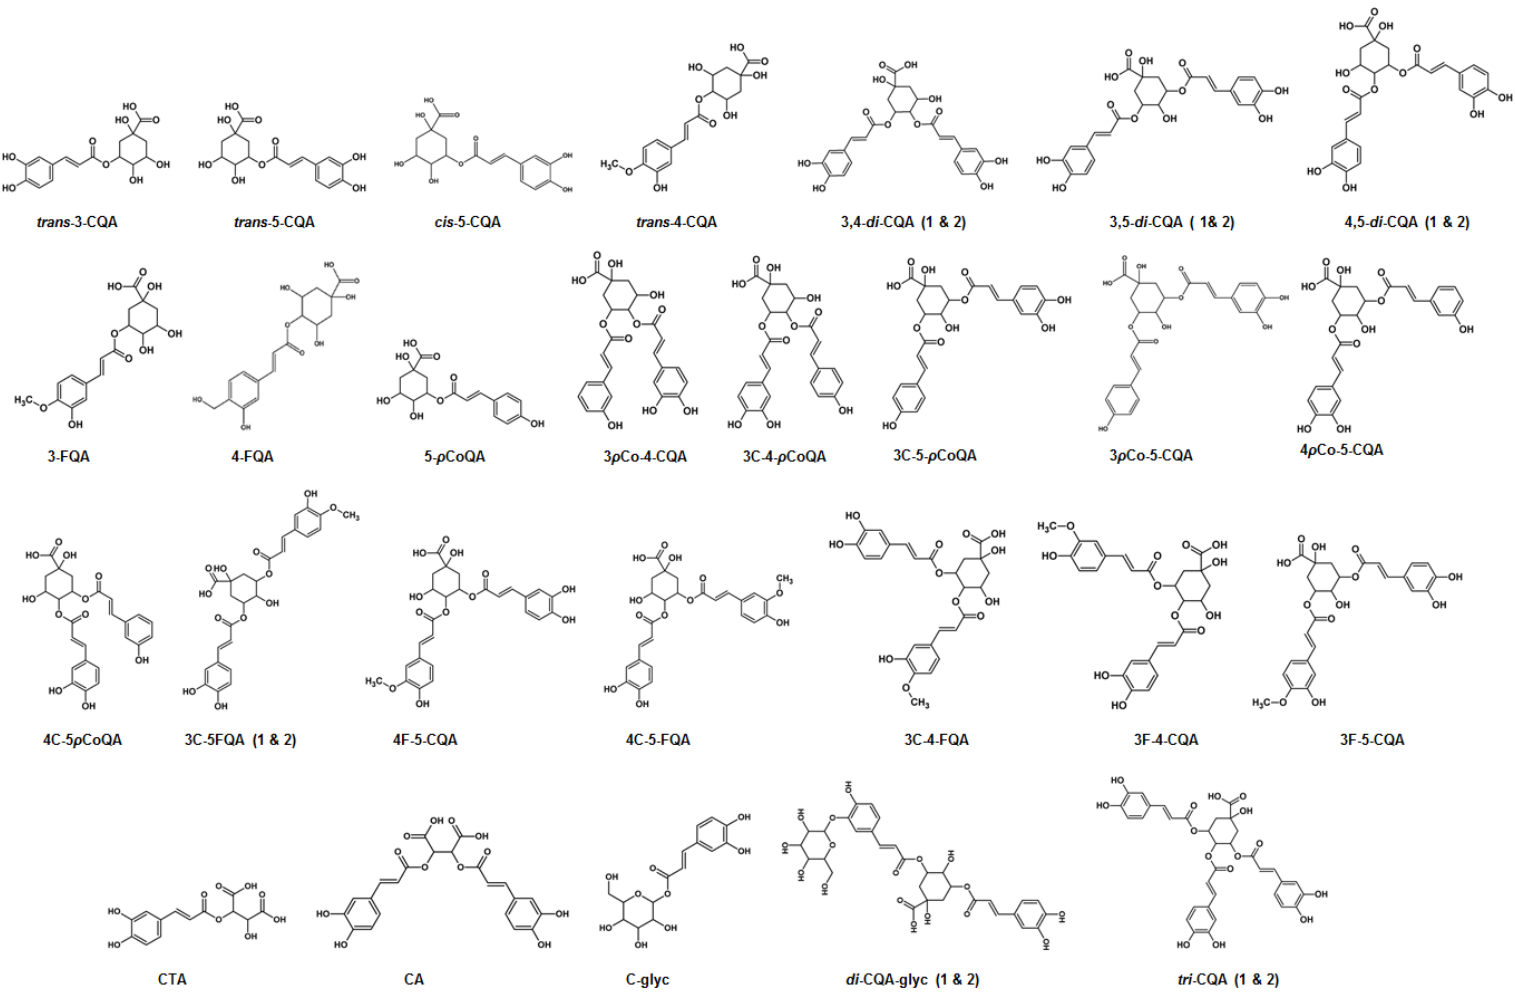
Figure 6. Chemical structures of mono -, di - and tri -substituted hydroxycinnamic acid (HCA) derivatives of quinic acid (QA) and tartaric acid (TA) identified in tissues and two suspension-cultured cell lines of Bidens pilosa .